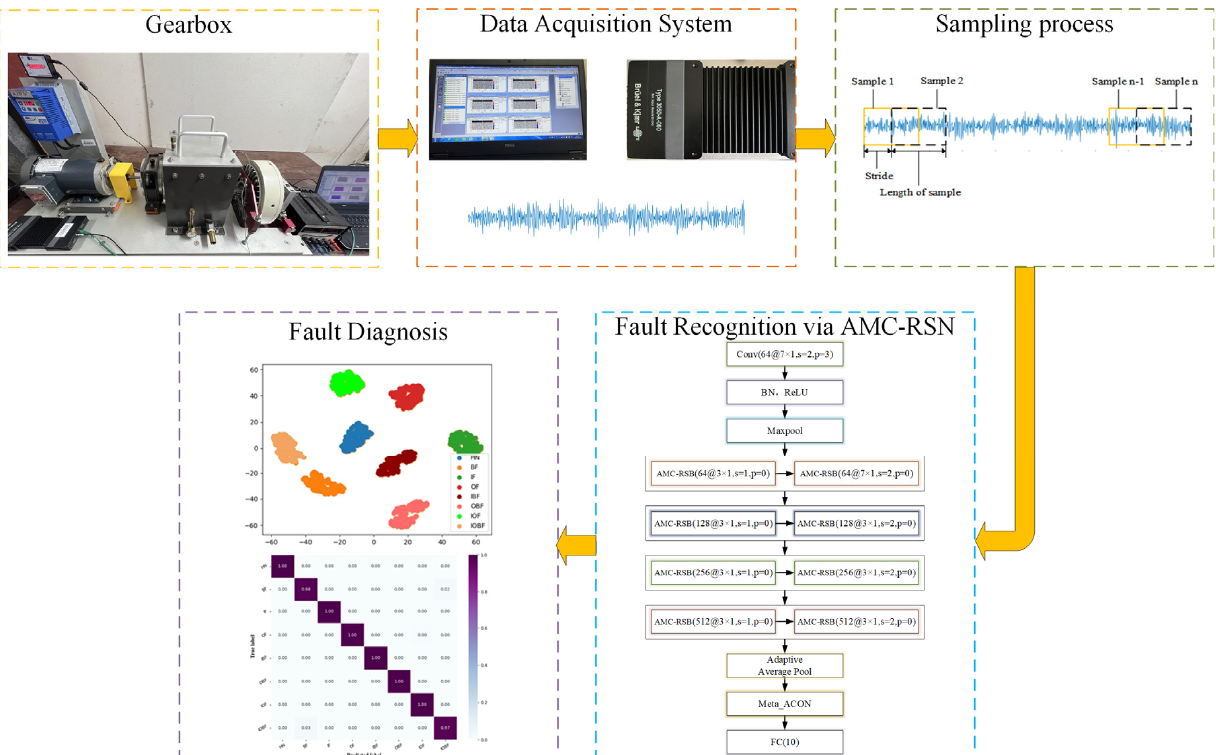
Figure 3. Diagnostic process of